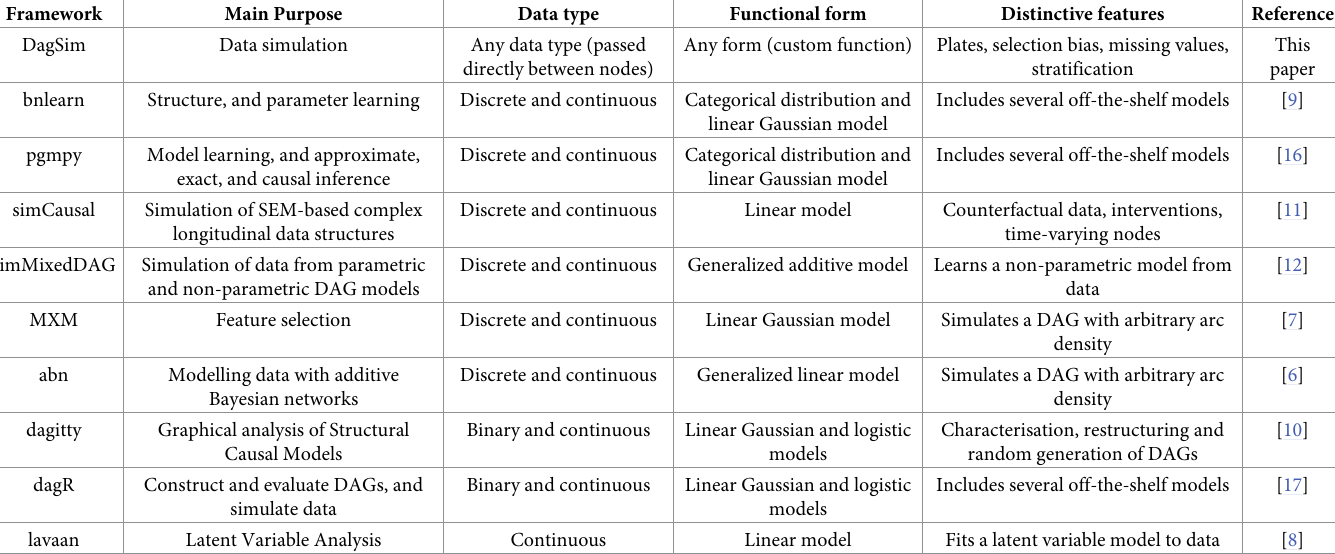
Table 1. An overview of all established frameworks that to the authors’ knowledge offer DAG-based simulation functionalities, describing for each package the main purpose, the type of data it simulates, the functional forms used, and the additional simulation utilities provided. The bnlearn package [9] can both infer parameters and simulate data from a model, with numerical variables and functional forms restricted to full conditional probability tables and linear regression models. The pgmpy package [16] is similar to bnlearn in terms of its purpose and simulation functionalities. The package simCausal [11] is more aimed toward causal inference problems and thus focuses on simulating longitudinal data based on SEMs. The main goal of the simMixedDAG package [12] is to simulate “real life” datasets based on a learned generalised additive model or user-defined parametric linear models. The package MXM [7] simulates data from multivariate Gaussian distributions based on a user-defined or randomly generated adjacency matrix, while abn [6] simulates data from Poisson, multinomial, and Gaussian distributions based on a user-defined adja- cency matrix. The packages dagitty [10], dagR [17], and lavaan [8] provide similar functionalities for simulating data based on